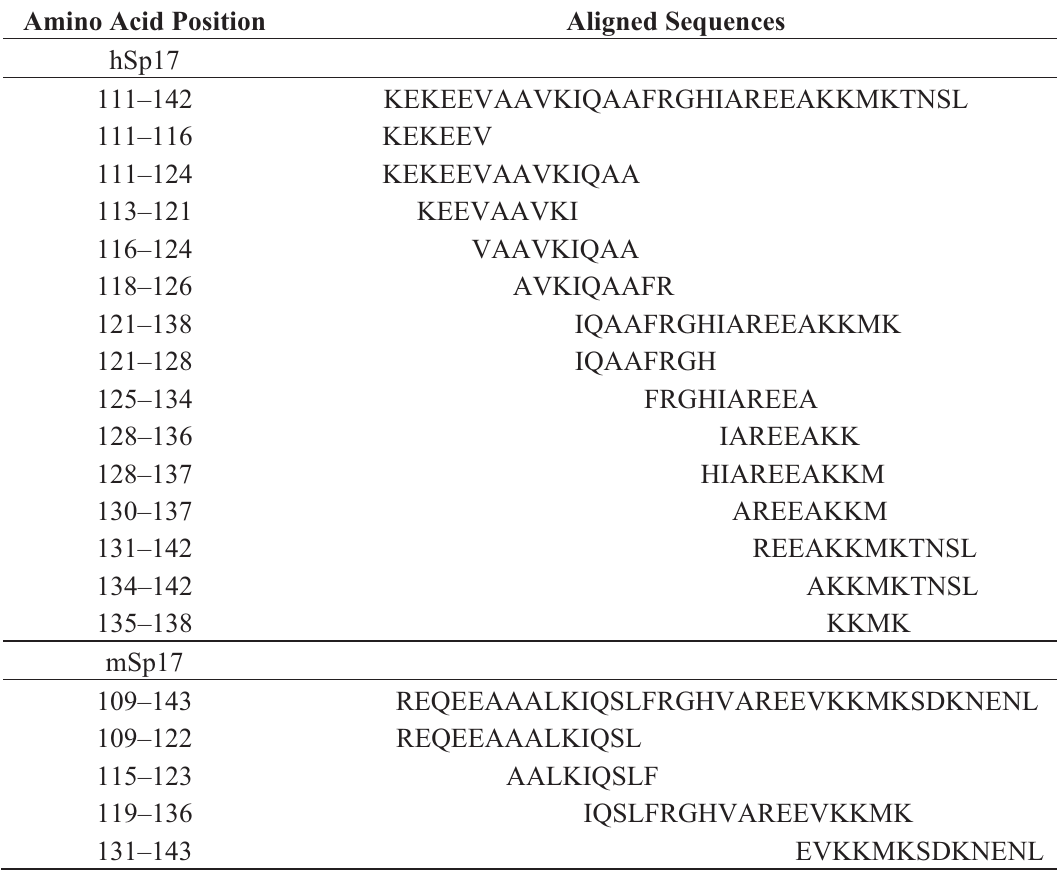
Table 2. Sp17 peptide sub-fragments and aligned